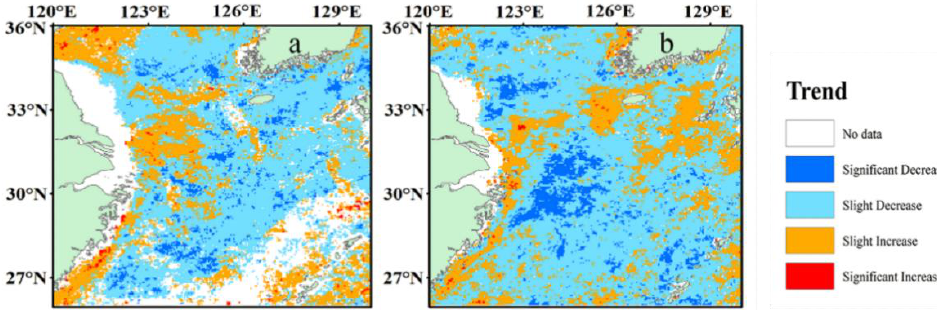
Figure 12. Spatial variation trend of SSS in March and August in the waters adjacent to the Yangtze Estuary from 2003 to 2020 (( a ) is March, ( b ) is August).